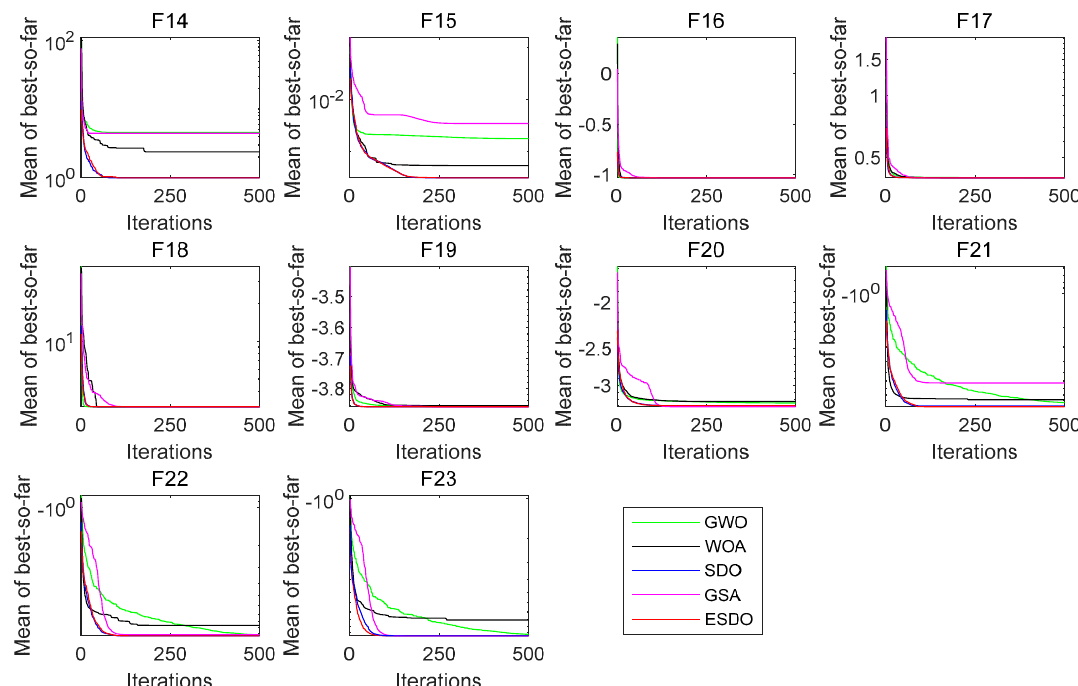
Figure 5. Convergence comparisons of LMNs (F14–F23).